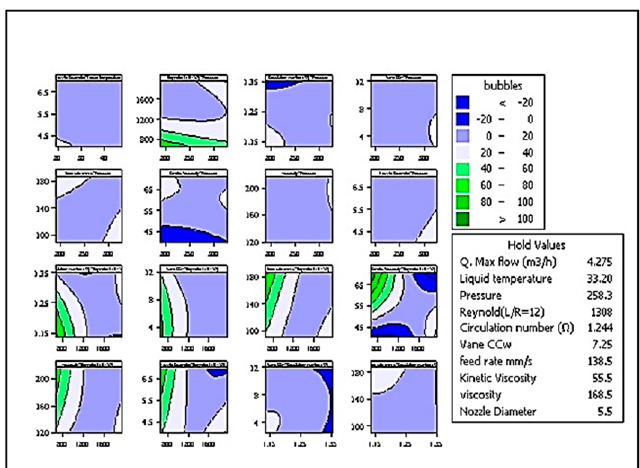
Figure 23. The intersection of significant factors.